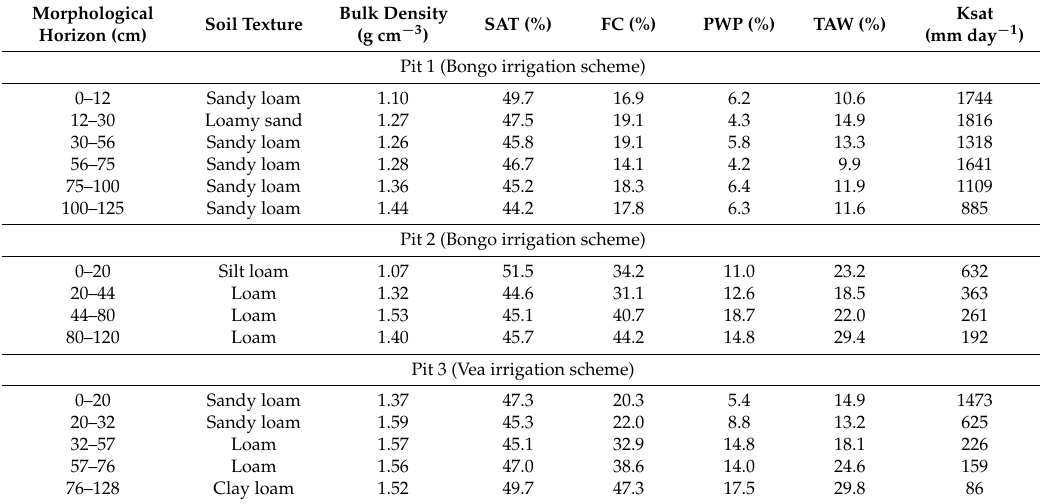
Table A2. Physical and hydraulic properties of soils in the Bongo and Vea irrigation schemes. Morphological Horizon (cm)